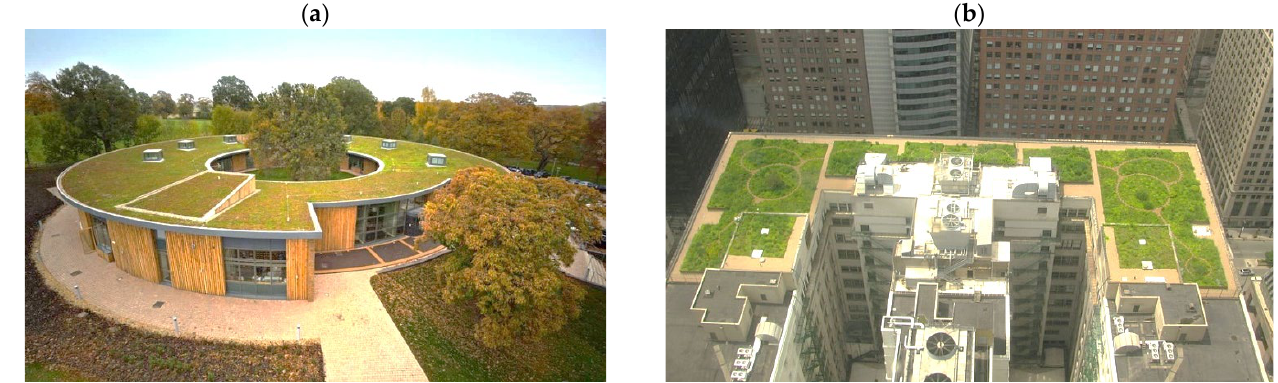
Figure 2. Examples of green roofs: ( a ) British Horse Society Headquarters, UK, and ( b ) Chicago City Hall, USA [31].